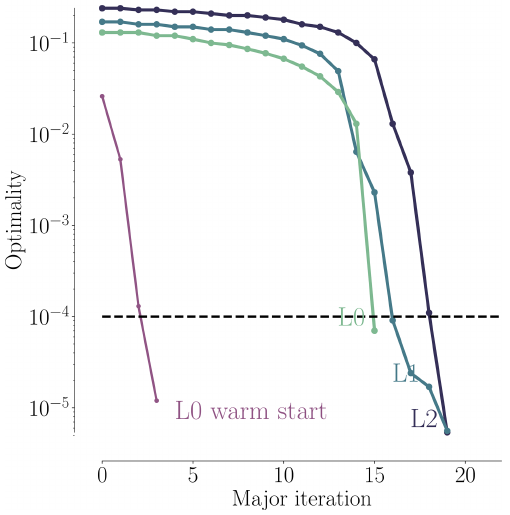
Figure 8. Convergence history for the pitch